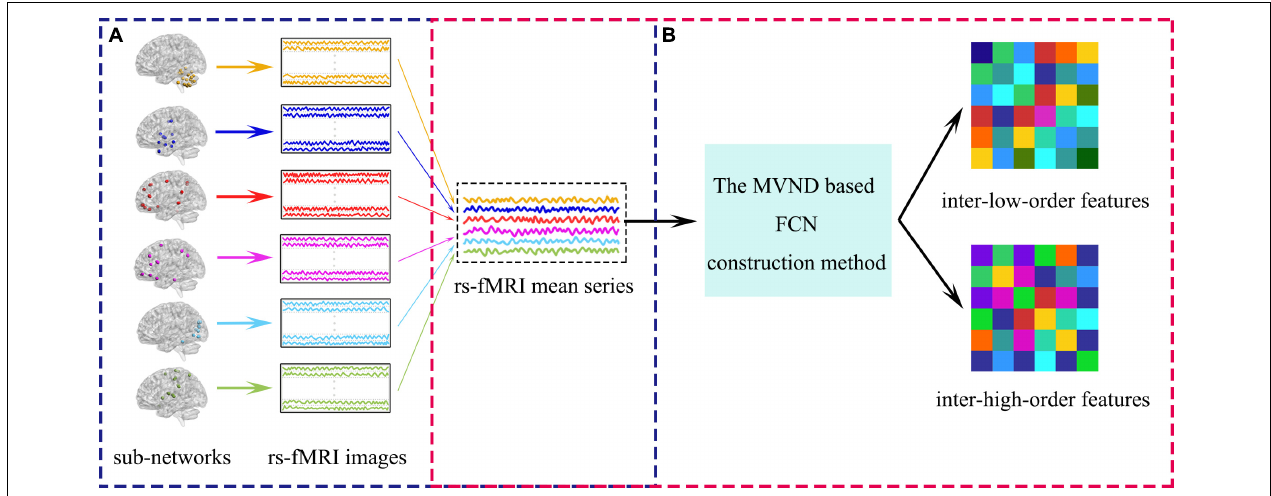
FIGURE 5 | The overview of the extraction of inter-sub-network features. (A) Shows the calculation of rs-fMRI mean series. (B) Shows the pipeline of the extraction of the inter-sub-network features.